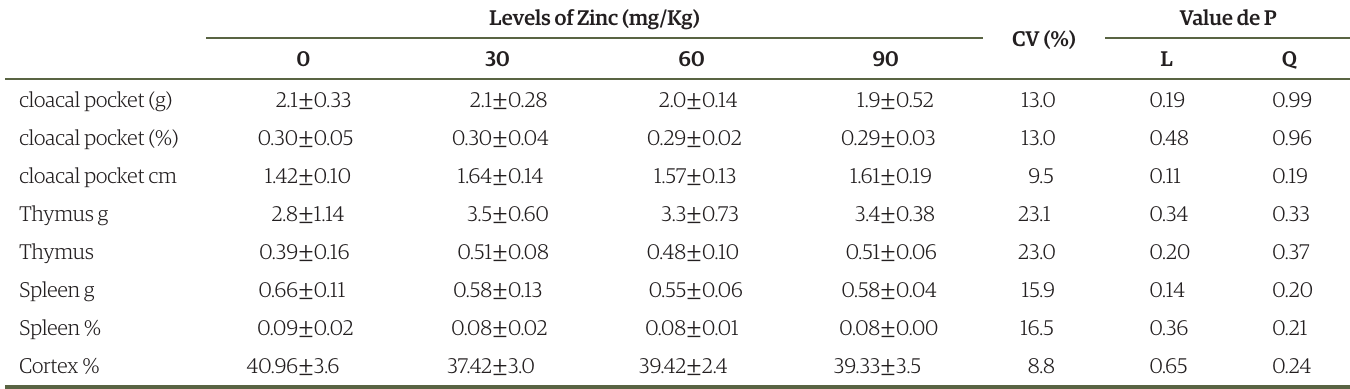
Table 5. Lymphoid organ weight, cloacal pocket diameter, and percentage of bursal cortex of broilers at 21 days, fed with increasing levels of organic zinc. Levels of Zinc